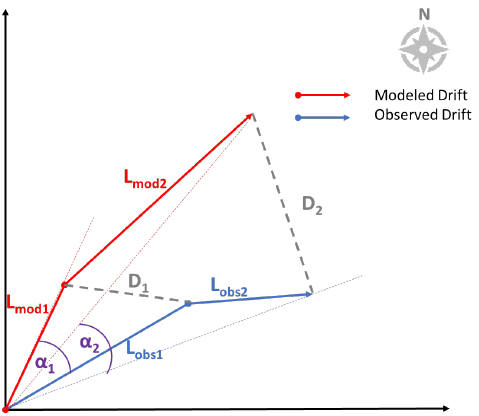
Figure 6. Diagram of NCLS mod calculation. L obs : path of the observed drifted; L mod : path of the modeled drifted; D: distance between modeled and observed drift; and α : the angle formed between L obs , L mod and the